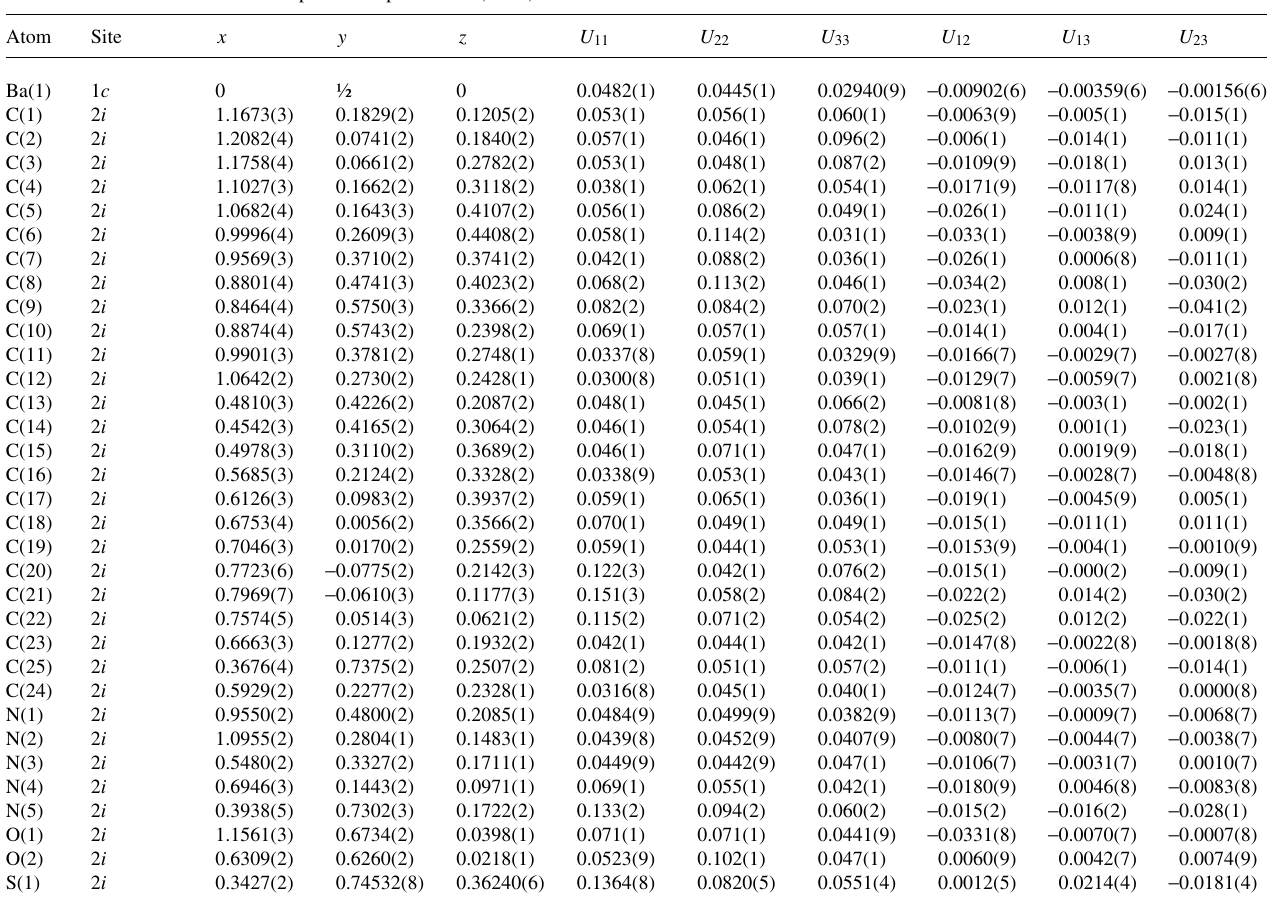
Table 3. Atomic coordinates and displacement parameters (in Å 2 ) .